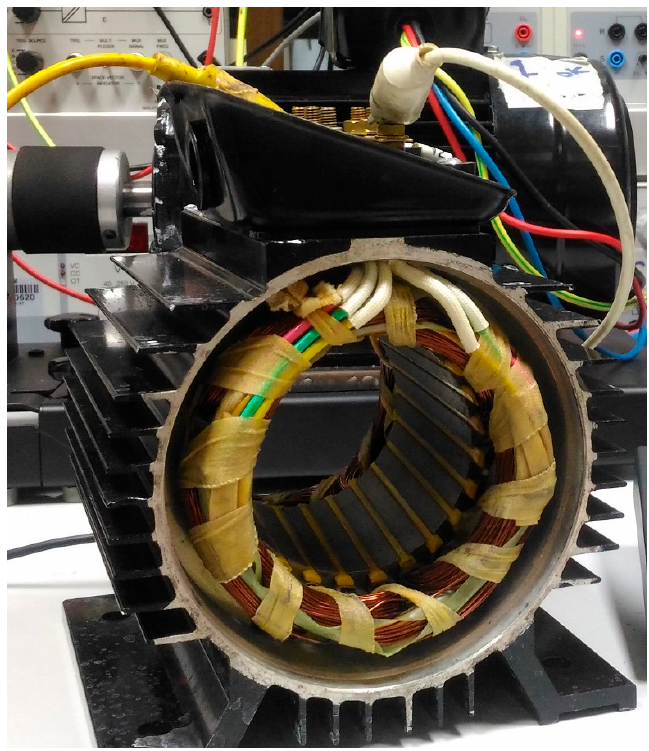
Figure 5. LSPMSM motor without rotor.